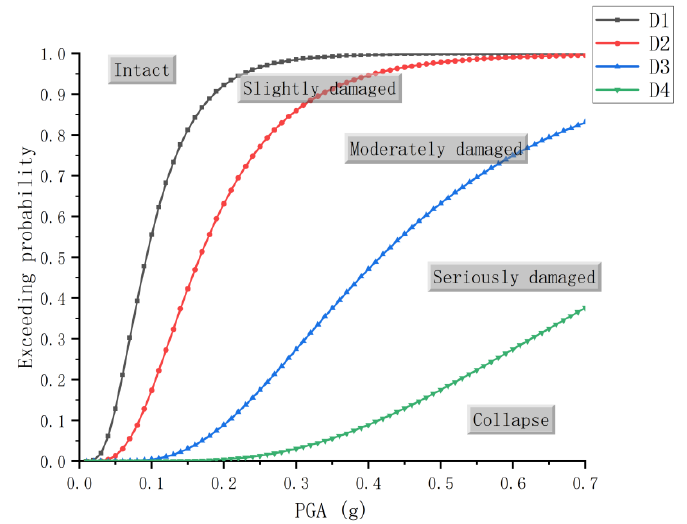
Figure 5. Probability of exceeding each failure state of prefabricated building structures at different PGA levels.